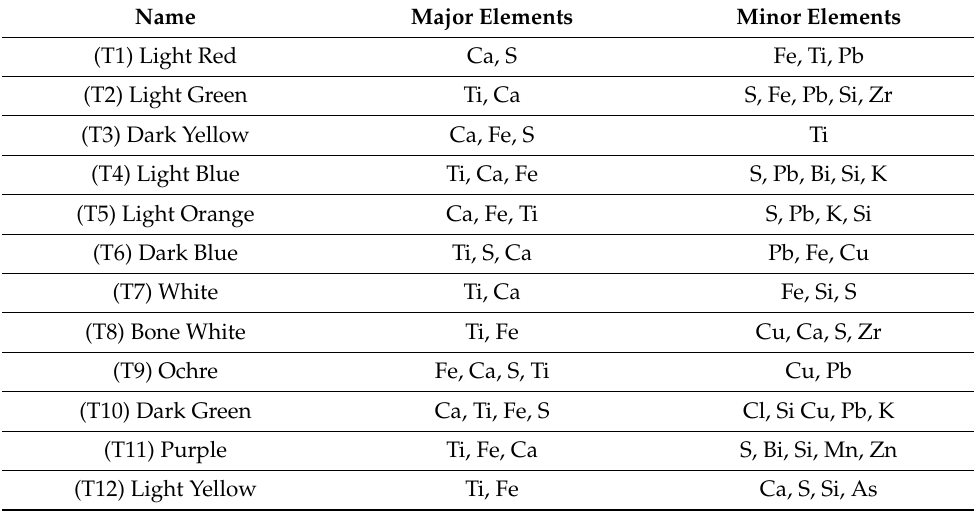
Table 3. Elements identified in the sample’s colours. The major elements were considered up to 10% of relative presence. The elements with less than 1% were not included. The elements were ordered by taking into account the relative